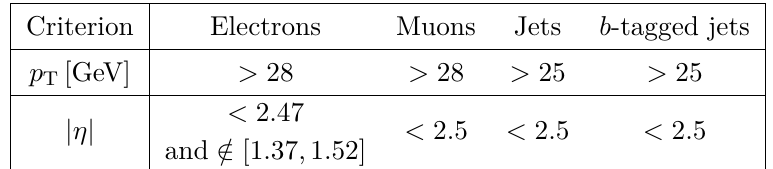
Table 1 . Summary of preselection criteria in ATLAS-CONF-2020-013, reproduced in part from section 3 of [3].